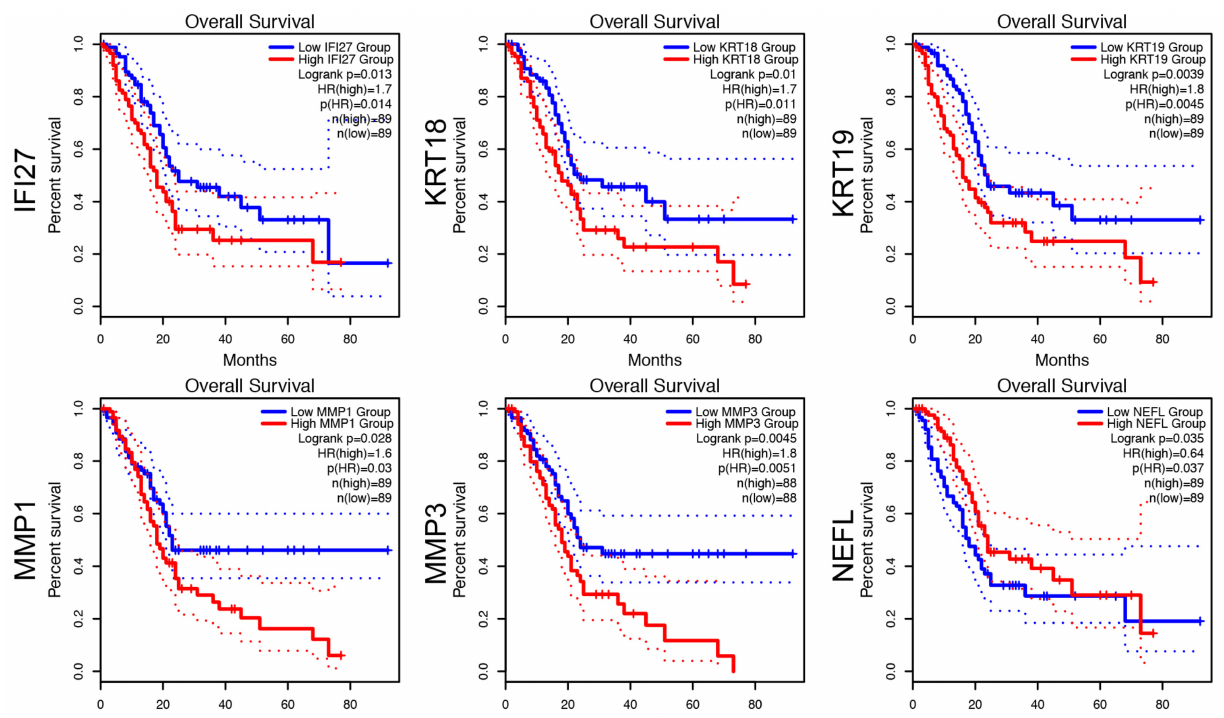
Figure 3. Analysis of 6 genes and overall survival. Overall survival analyses of 6 genes ( IFI27 , KRT18 , KRT19 , MMP1 , MMP3 , and NEFL ) in pancreatic cancer based on the GEPIA database. Median expression was used as the threshold between high and low expression. The 95% confidence interval is plotted by the dotted